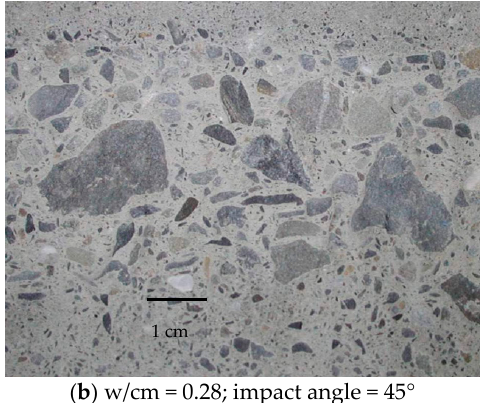
Figure 5. Images of worn concrete surfaces after impact test.